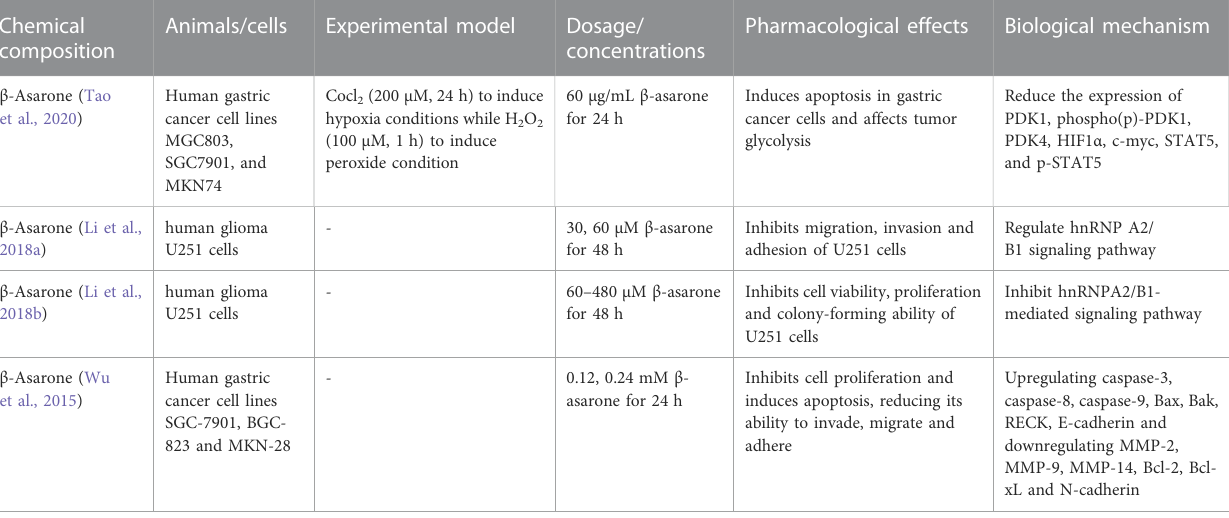
TABLE 6 Anti-tumor effects of